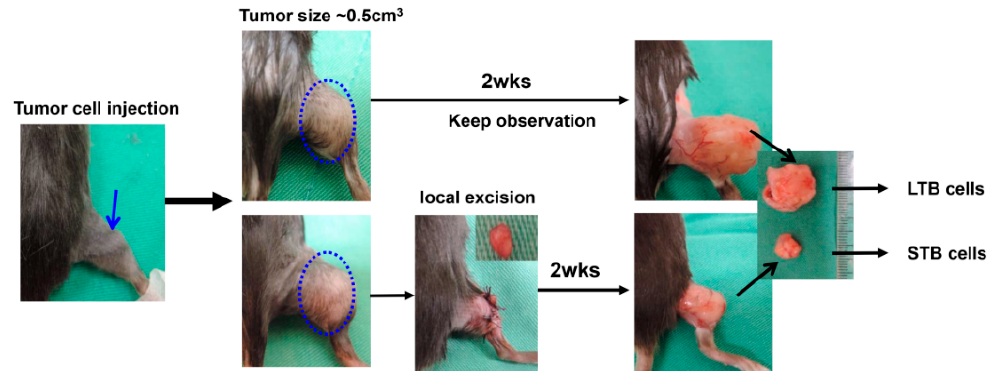
Figure 1. Tumor models for small tumor burden and large tumor burden. Transgenic adenocarcinoma of the mouse prostate (TRAMP)-C1 cells (1 × 10 6 cells per implantation, or as indicated) were implanted subcutaneously. We performed local excision when ectopic tumors reached a size of 0.5 cm 3 . The cancer cells were collected from xenograft tumors at two weeks after local excision (cells of smaller tumor burden; STB); tumors not subjected to local excision and continued growth for two weeks (cells of larger tumor burden; LTB).